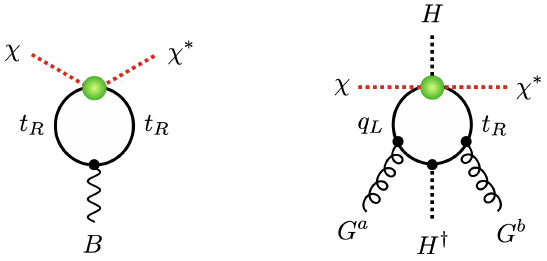
Figure 4 . Left: example diagram that describes the LL contribution of the current-current type DM-fermion operators to the Wilson coefficient of the DM-photon operator appearing in (7.1). Right: a possible graph involving the insertion of the Yukawa-type DM-top operator that leads to a finite matching correction to the Wilson coefficient of the DM-gluon operator in (7.1). See text for further